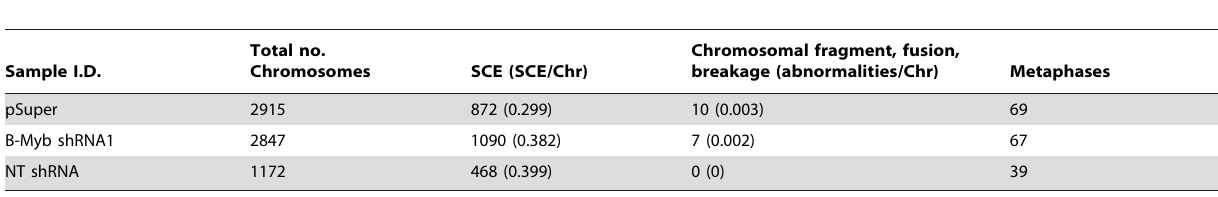
Table 2. Frequency of SCE and chromosome abnormalities